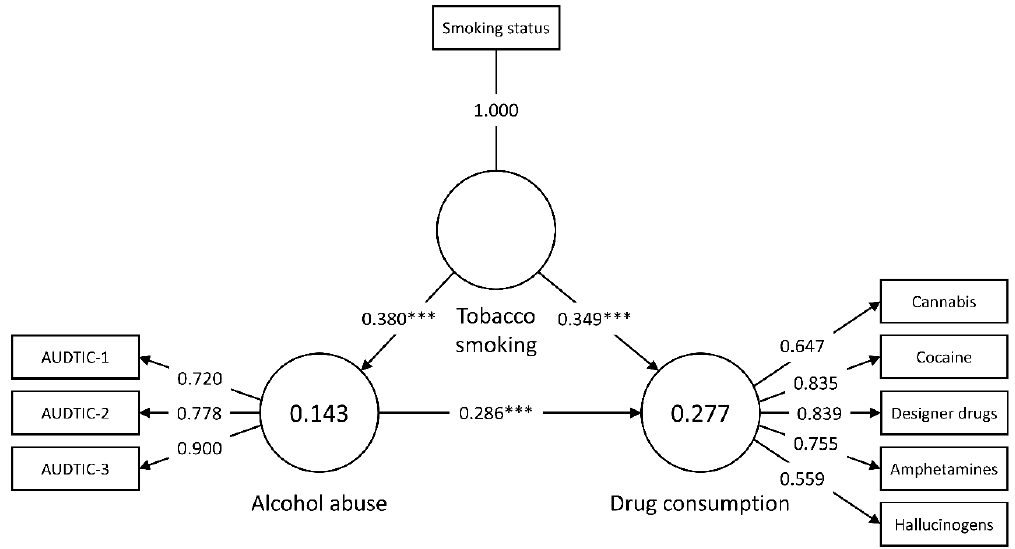
Figure 2. Path analysis of the mediating relationship. *** p < 0.001. Table 5. Assessment of the measurement model (reflective).